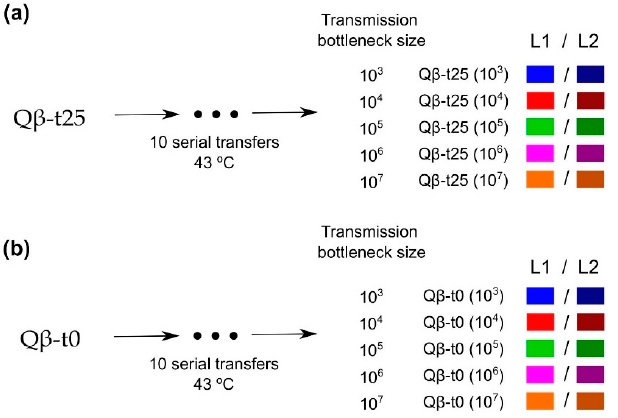
Figure 2. Scheme of the evolution experiment. Populations ( a ) Q β -t25 and ( b ) Q β -t0 were propagated at 43 ◦ C through 10 serial transfers each (see Section 4.4) that were carried out using different transmission bottleneck sizes. Evolutionary lineages obtained at Transfer 10 are denoted with the name of the ancestor followed by the transmission bottleneck size used at each transfer. L1 and L2 were used to distinguish the two replicas of each condition. Colour code is maintained all through this paper.